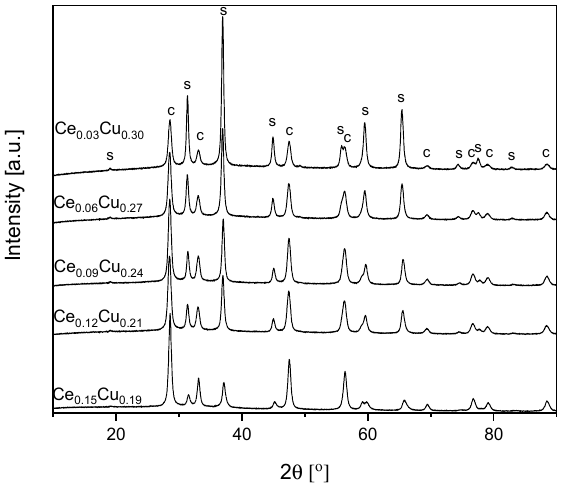
Figure 4. XRD patterns of Cu–Al catalysts doped with cerium, ‘s’ stands for spinel and ‘c’ for CeO 2 .